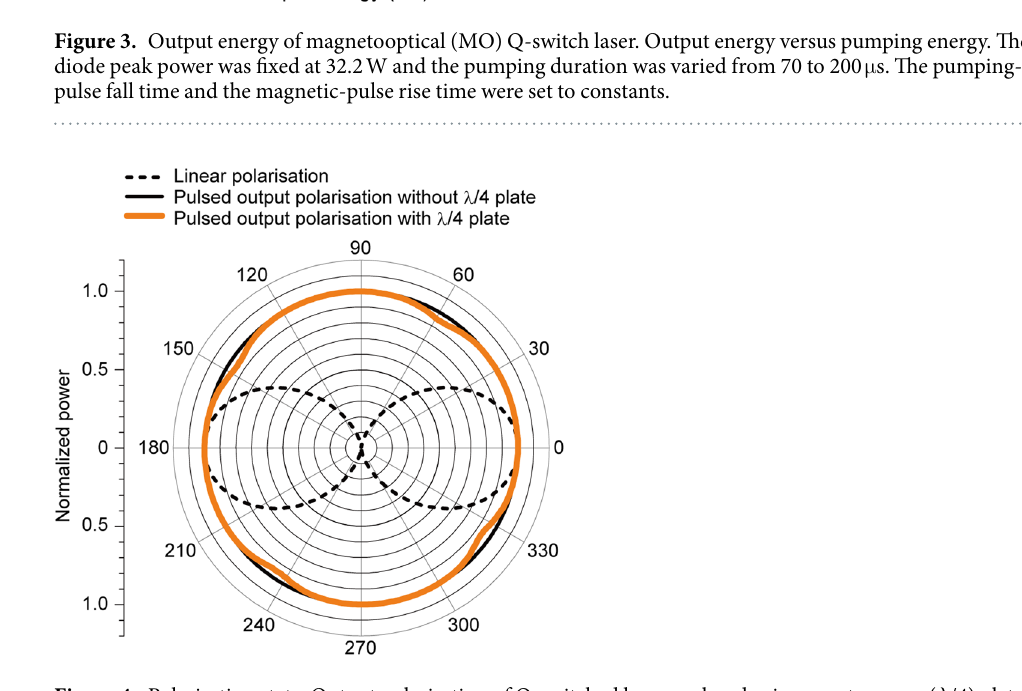
Figure 4. Polarisation state. Output polarisation of Q-switched laser analysed using quarter-wave ( λ /4) plate and analyser. The ideal linearly polarised state is indicated by the black dashed line. Without the λ /4 plate, the transmitted power showed no dependency on the analyser angle (solid black line). The polarisation state using the λ /4 plate is plotted by the bold orange line. The polarisation state remained constant with rotation of the λ /4 plate, indicating that the output pulse was not circularly but randomly